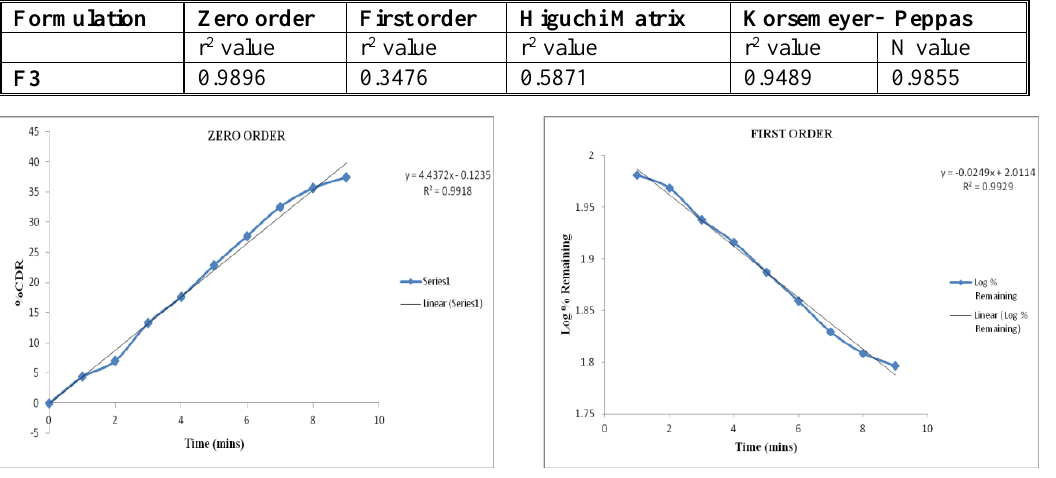
Figure 8. Zero order plot of F3 Figure 9. First order plot of